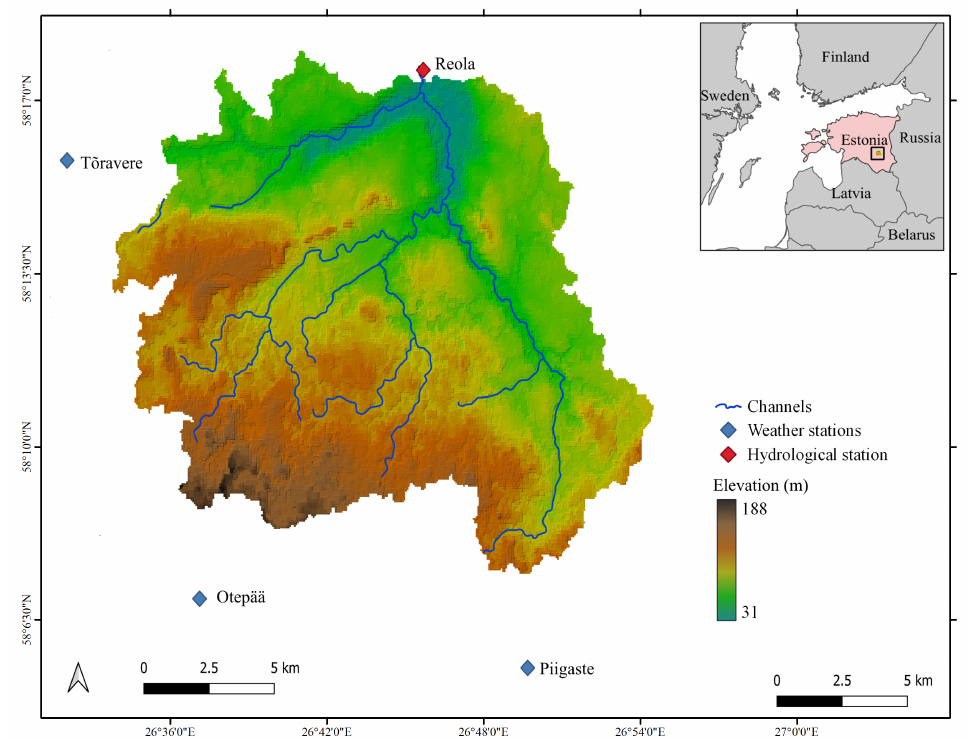
Figure 1. Map of the study area: the Porijõgi